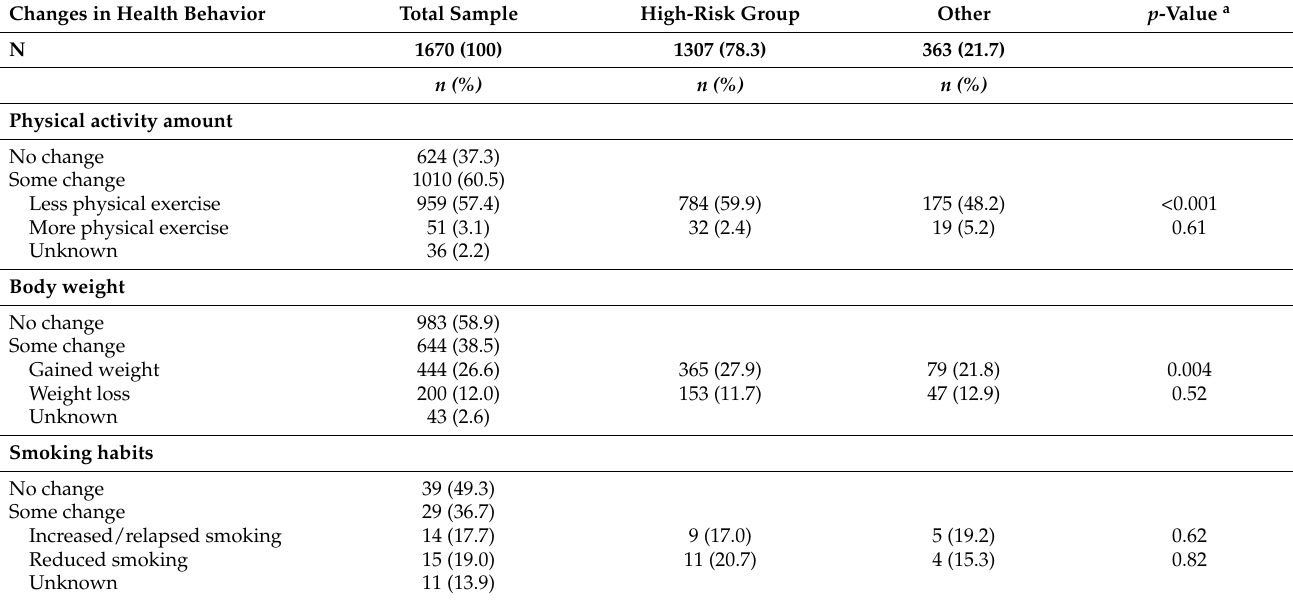
Table 2. Changes in health behaviors of 1670 physically active Israeli elderly members of a health club chain between March and the beginning of August 2020, according to self-classification to COVID-19 level of risk